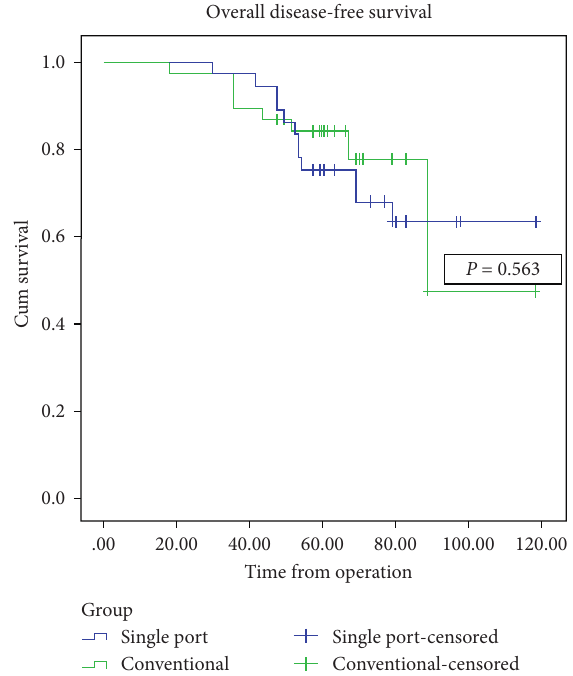
Figure 2: Kaplan–Meier curve of disease free survival.